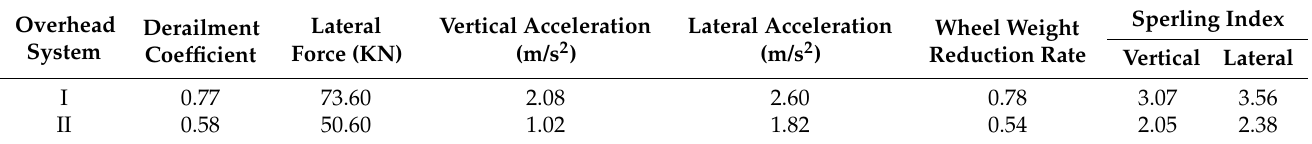
Table 9. Dynamic response of freight train under AAR5 track